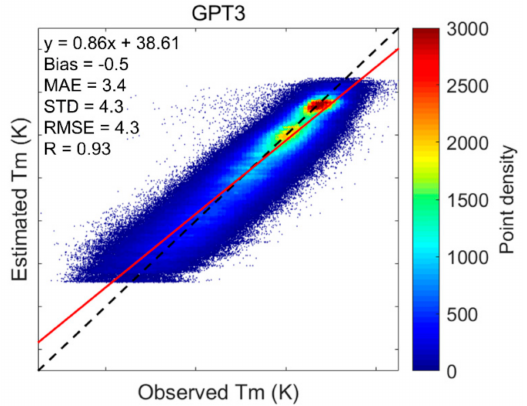
Figure 6. Scatter plots of estimated T m against observed T m for GPT3 model. The dashed line is the 1:1 line. GPT3: global pressure and temperature model